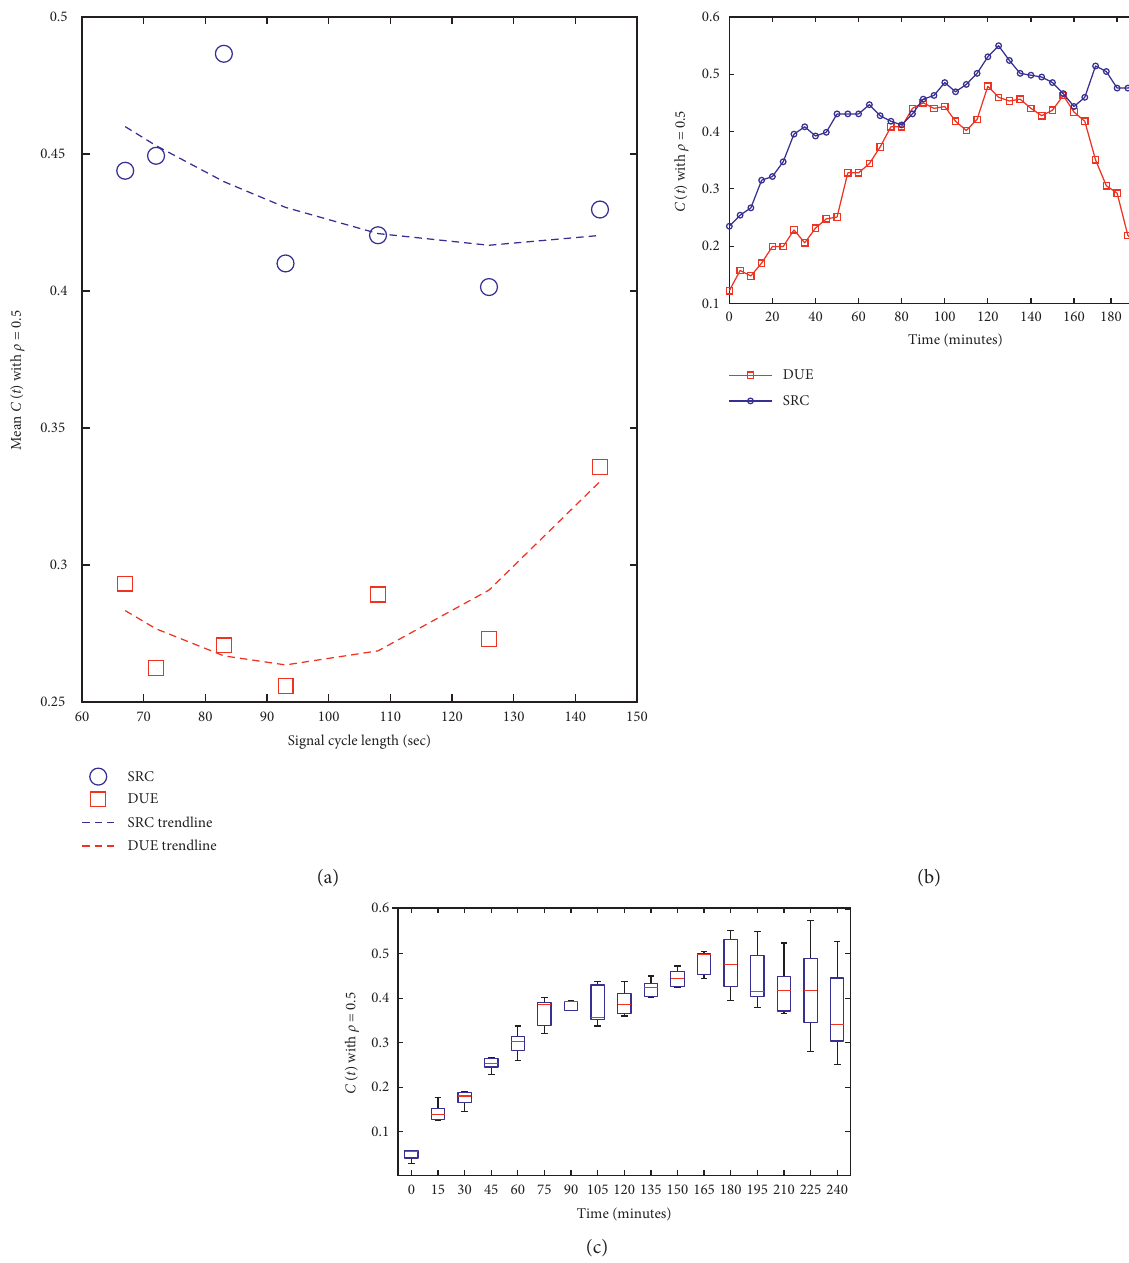
Figure 12: Network traffic signal optimization results. (a) Mean fraction of congested links for different signal cycle length with congestion threshold ρ � 0 . 5. Dashed curves represent the fitted surface function. (b) Evolution of c ( t ) over time for DUE and SRC when ω � 108sec. (c) Boxplots representing variations in the C ( t ) over 5 SRC replications when ω �